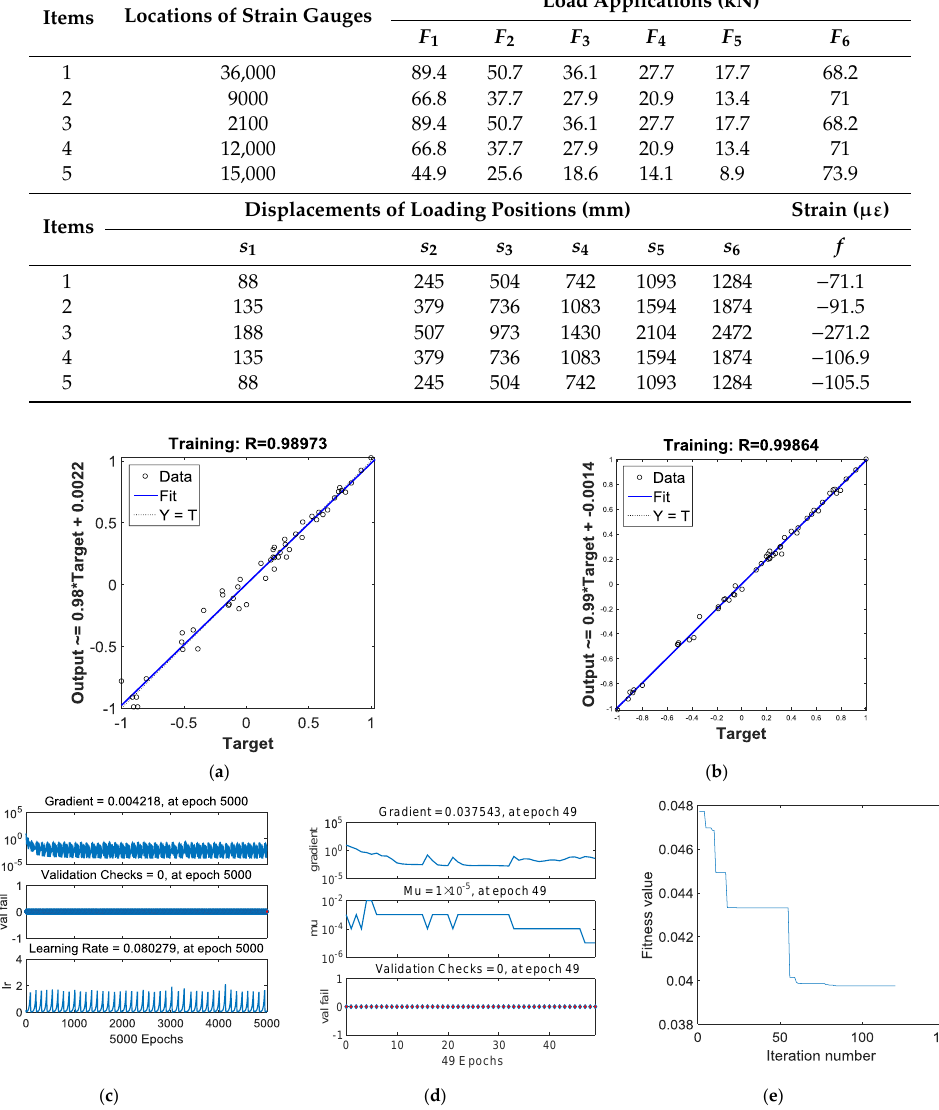
Figure 7. ( a ) Plotting linear regression of BPNN; ( b ) plotting linear regression of PSO-BPNN; ( c ) training state of BPNN; ( d ) training state of PSO-BPNN; ( e ) the Fitness value graph of PSO iteration.